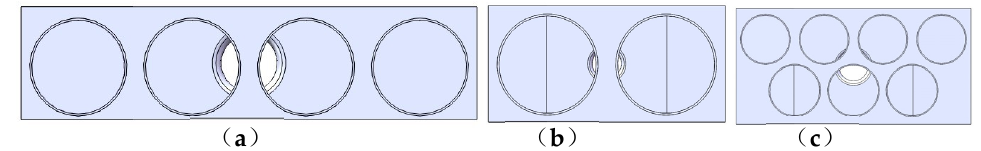
Figure 6. Negative pressure fan layout diagram. ( a ) Single row arrangement of small fans. ( b ) Single row arrangement of large fans. ( c ) Small fan double row layout.